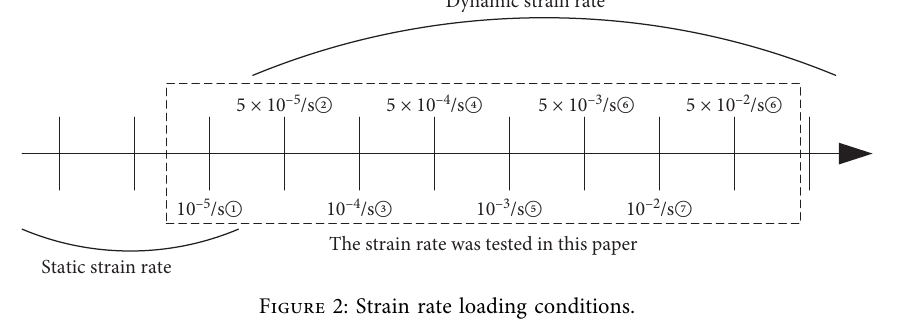
Figure 2: Strain rate loading conditions.